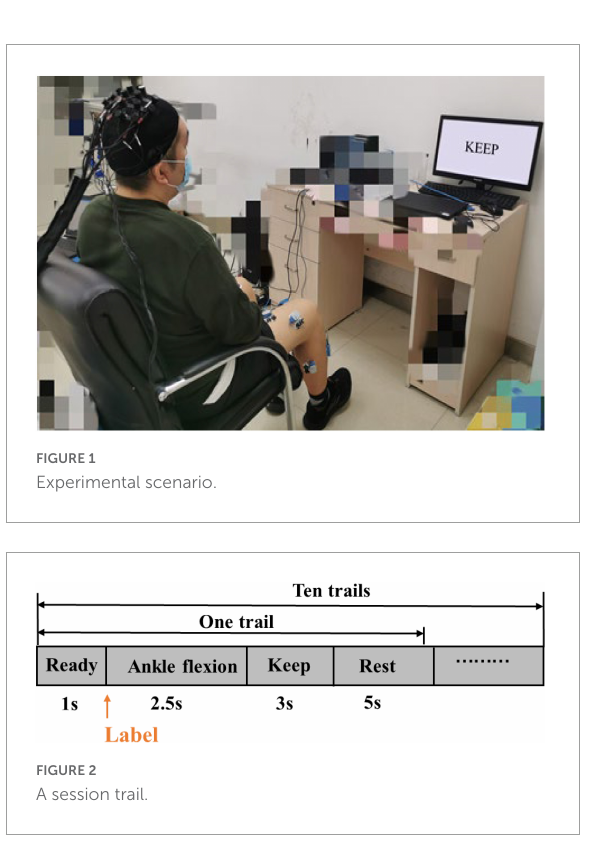
( Figure 2 ). A 5-min rest between successive sessions in case of muscle fatigue